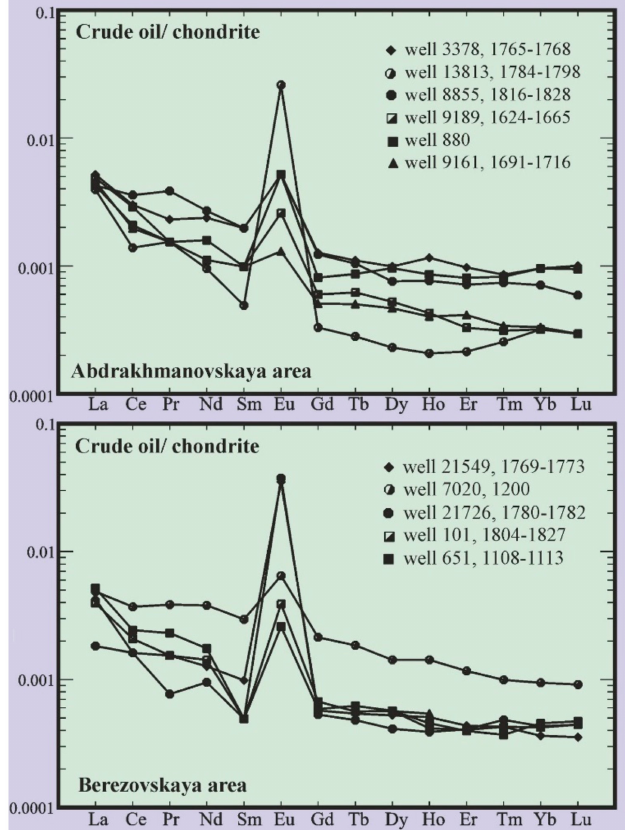
Figure 4. Distribution curves of rare earth elements normalized to chondrite [16] for crude oil from the Romashkinskoye oil